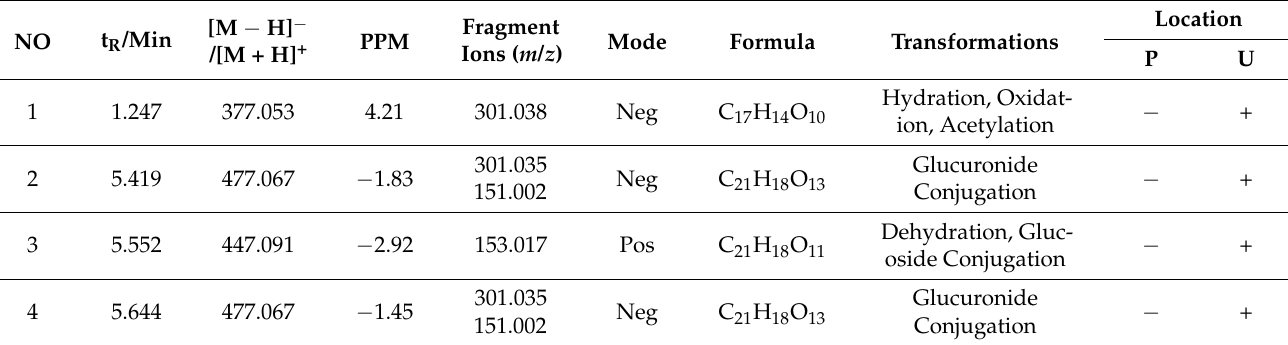
Figure 7. Changes of total antioxidant capacity of flavonoids in plasma and urine: ( a ) plasma and ( b ) urine. The results are reported as means ± SD. Different letters in the figure indicate significant differences ( p < 0.05). Table 2. Identification of metabolites of quercetin in plasma and urine.